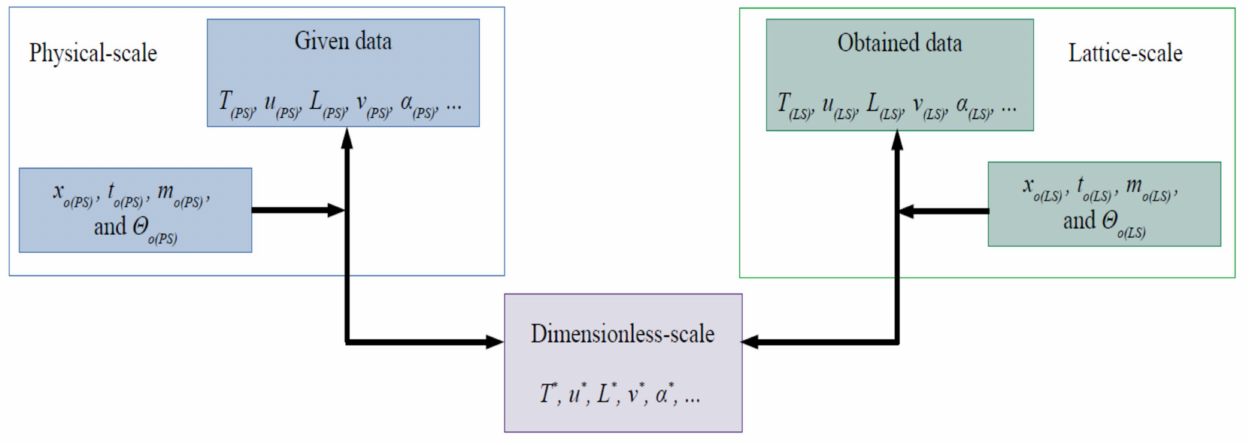
Figure 2. Flowchart of unit conversion approach.